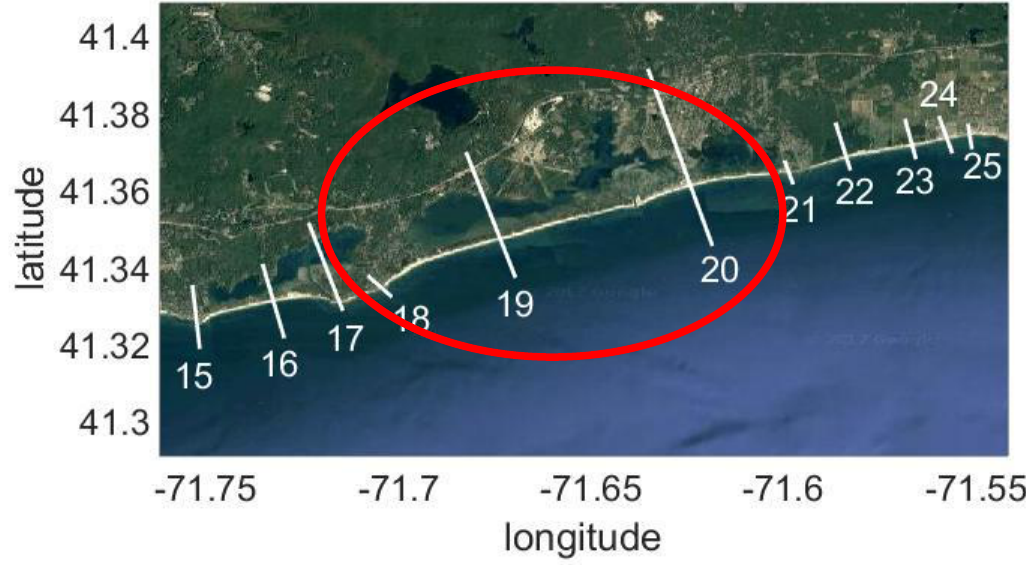
Figure 1. Location of the Federal Emergency Management Agency (FEMA) (2012) [2] Washington County, RI Wave Height Analysis for Flood Insurance Studies (WHAFIS) transects in the vicinity of the study area. The Charlestown study area is shown in the red circle. The FEMA transects of primary interest are numbers 19 (west) and 20 (east).